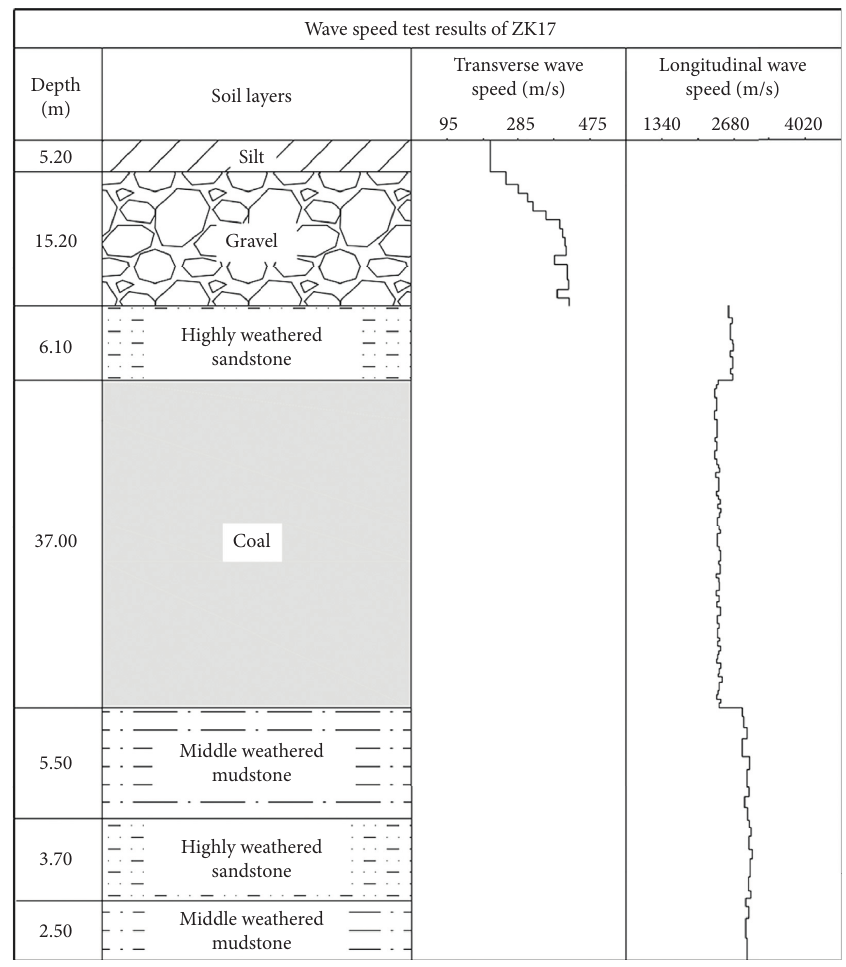
Figure 24: Wave speed test results of